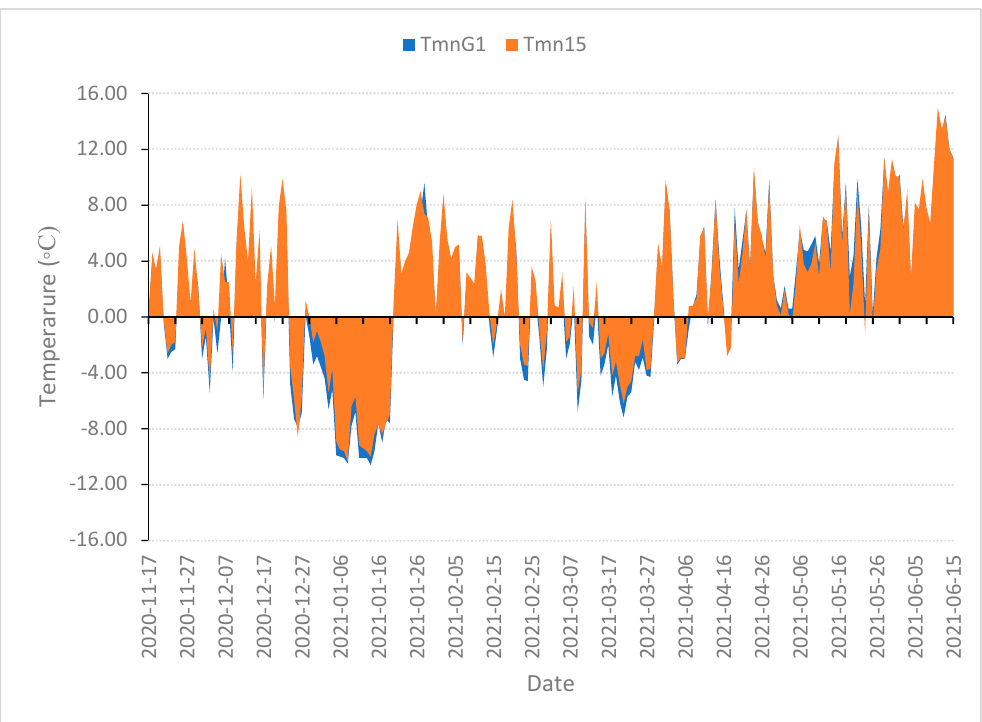
Figure A1. Soil temperature data at the surface (TmnG1) and at 15 cm depth (Tmn15) recorded by the meteorological station of Escola Superior Agrária de Bragança.